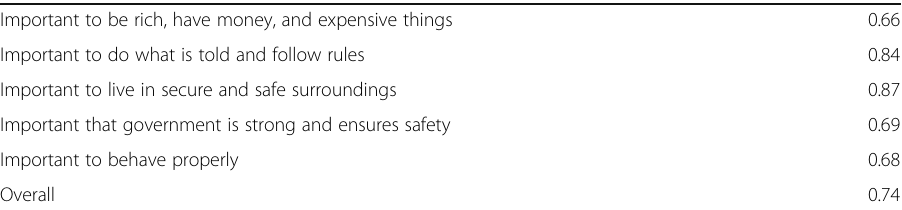
Table 7 KMO test for hierarchy vs